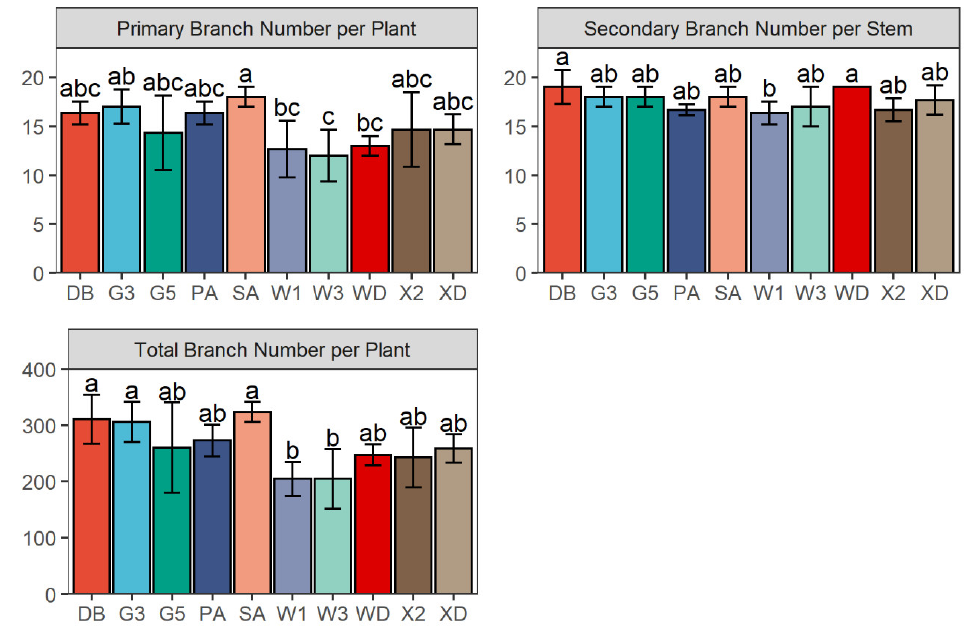
Figure 5. The Primary Branch number per plant (PB), Secondary Branch number per stem (SB), and Total Branch number per plant (TB) of 10 alfalfa varieties at the flowering stage before the first cutting in 2017. Different letters indicate means that are significantly different at p < 0.05. Error bars indicate the standard deviation of the means. DB: Derby, G3: Gannong No. 3, G5: Gannong No. 5, PA: Phabulous, SA: Sanditi, W1: WL168HQ, W3: WL343HQ, WD: Wudi, X2: Xinmu No. 2, XD: Xinjiang Daye.